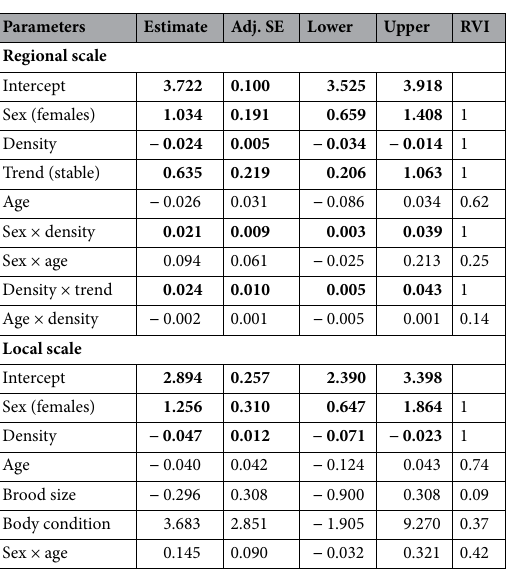
Table 1. Conditional model averaging of the top-ranked models (delta AICc < 2), examining the correlates of natal dispersal distances of Egyptian vultures at the regional (whole study area, Spain and France) and local scale (Ebro valley). Model average parameter estimates, adjusted standard errors, 95% confidence intervals and relative variable importance (RVI, the sum of Akaike weights over the set of models in which the variable appears) are shown. Effects with 95%CI not overlapping zero are shown in bold.